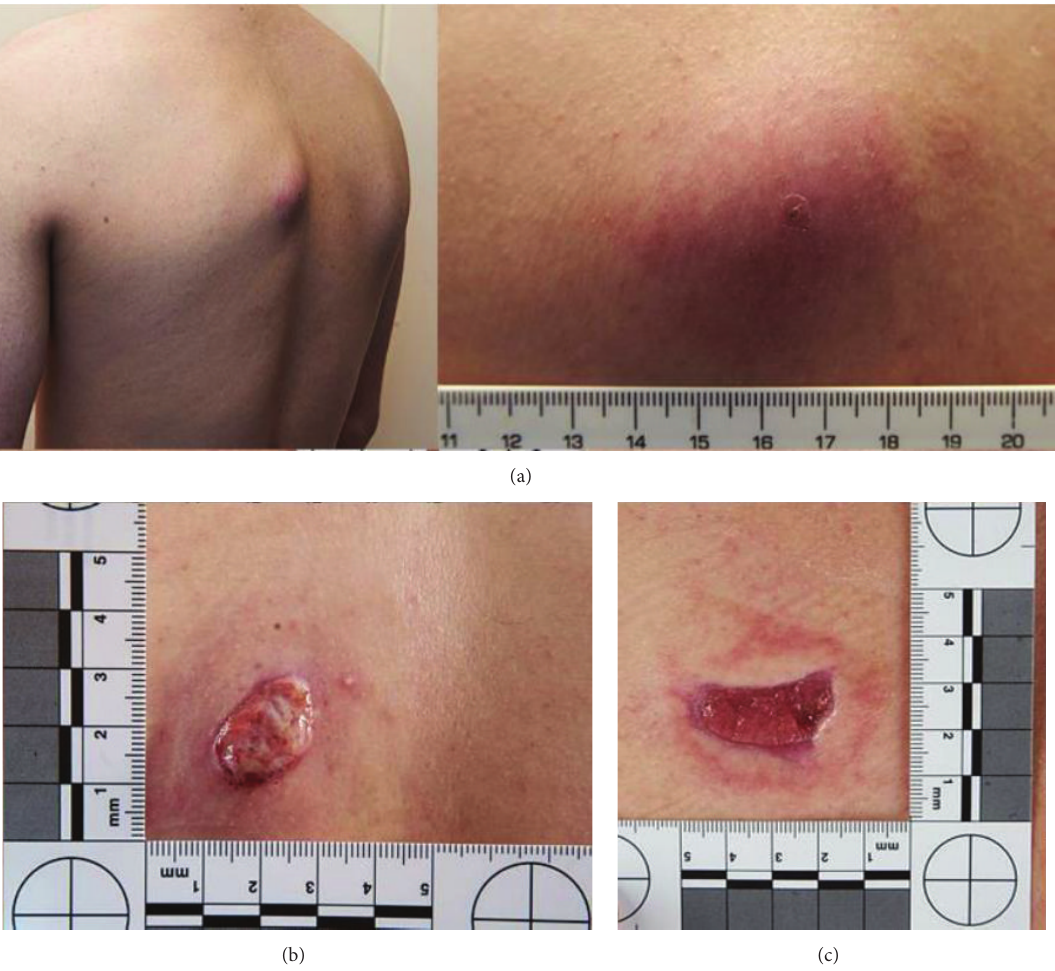
Figure 1: (a) Appearances of the closed abscess after one week of antibiotics (note central puncture site from previous diagnostic aspirate). (b) Proliferating granulation tissue, four weeks after top images were taken. (c) Healing ulcer, four months after the top images were taken.